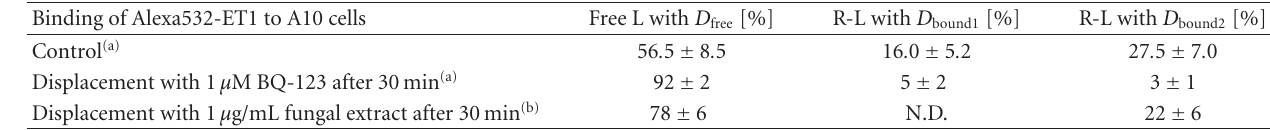
Table 1: FCS binding studies with Alexa532-ET1 on endothelin ET A receptor. Binding of Alexa532-ET1 to A10 cells Free L with D free [%] Control (a) Displacement with 1 μ M BQ-123 after 30 min (a) Displacement with 1 μ g/mL fungal extract after 30min